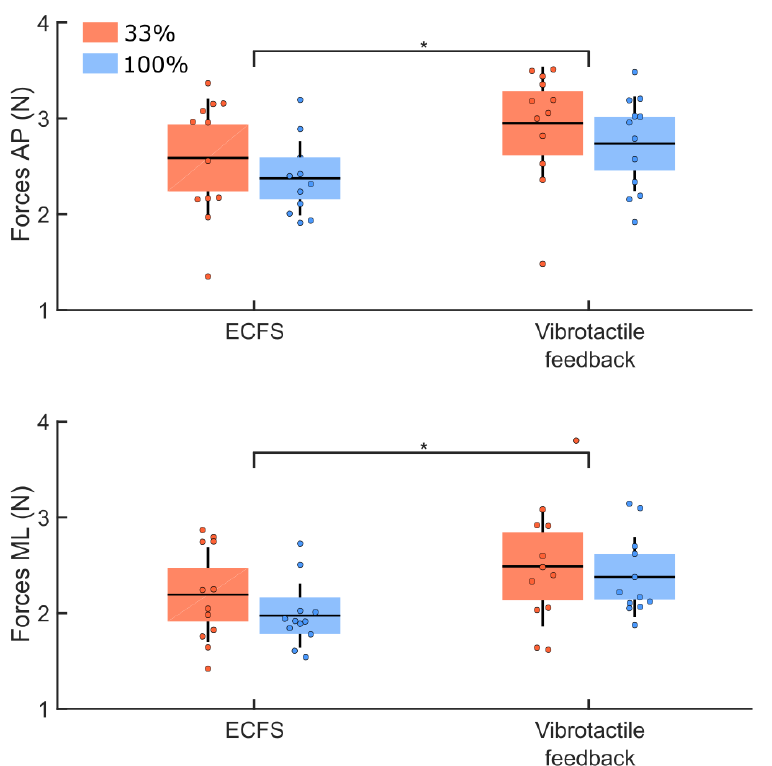
Figure 8. RMS values of the ground reaction forces along the AP (upper panel) and ML (lower panel) axes for both groups (33% and 100% feedback groups, red and blue boxes, respectively). These RMS values are for the control (ECFS) and the vibrotactile feedback conditions. The dots represent the mean results for each participant, horizontal lines depict the group’s means, boxes represent the group’s standard error of the mean, and vertical lines, one standard deviation. The asterisks (*) indicate significant main effect of condition.